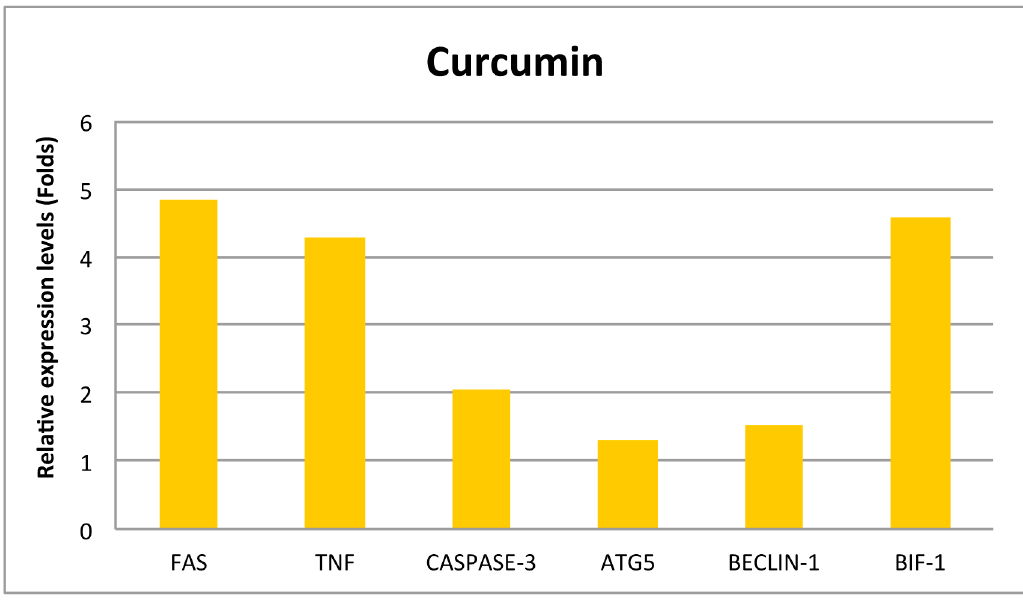
Figure 2. Expression levels of the genes after Curcumin treatment in HeLa cells.